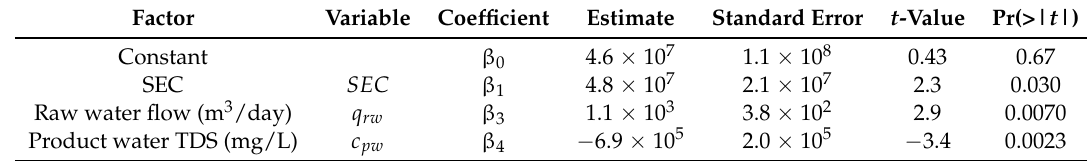
Table A4. Multiple linear regression results for the municipal-scale model of EPC cost ( n = 28) revealed a moderate model fit with significant coefficients. Values have been rounded to two significant